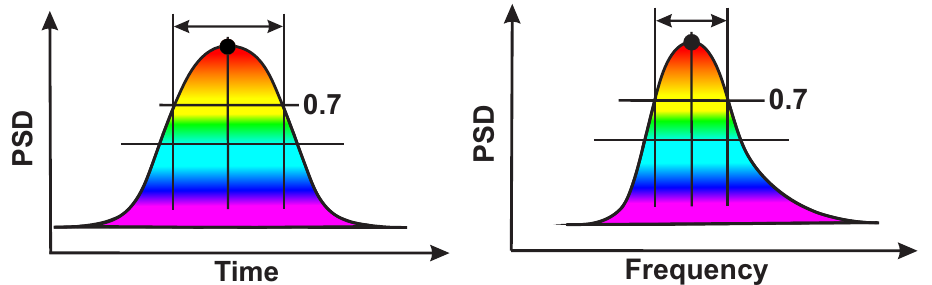
Figure 6. An example of a wave train spectrogram in the time–frequency domain. On the left is a time slice of the wavelet spectrogram. The abscissa is time and the ordinate is PSD. On the right is a frequency slice of the wavelet spectrogram. The abscissa is the frequency and the ordinate is